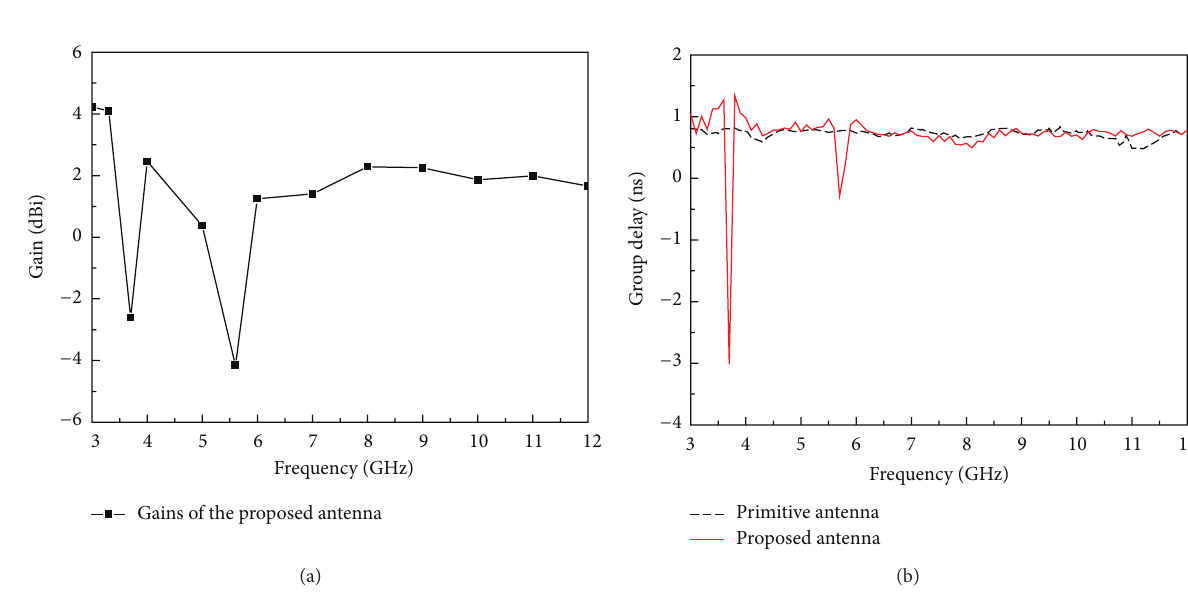
Figure 11: (a) Measured gain and (b) group delay of the proposed